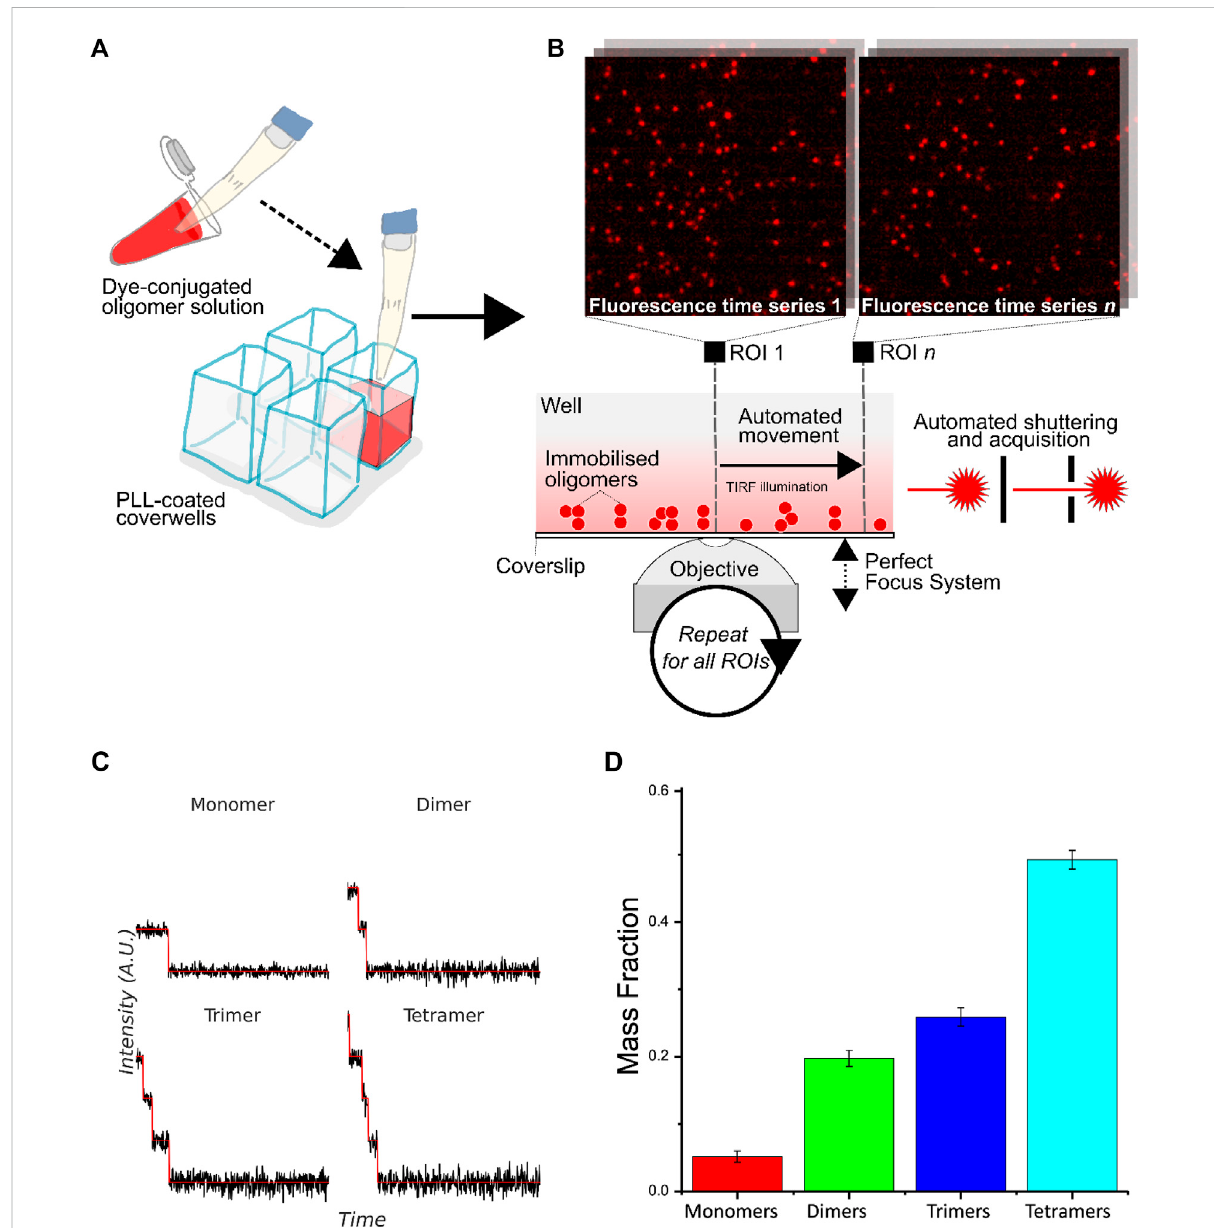
FIGURE 1 Work fl ow of high-throughput protein oligomer analysis by single-molecule stepwise photobleaching. (A) Dye-labeled protein sample is immobilized onto a solid-phase substrate or lipid membrane inside cover glass-bottomed chambers. (B) Overview of the automated acquisition process. Anautomatedpiezoelectricstageisusedtorapidly acquirelarge numbersofphotobleachingtracesoverpresetregionsofinterest(ROIs)in theglasswell.ImmobilizedoligomersareviewedwithTIRFilluminationwithfocusmaintainedoverlargedistanceswithacomputer-controlled focusing system, with each fl uorescence time series acquired automatically via custom control software automating laser shuttering and image acquisition. Example images of immobilized oligomers from two different ROIs are shown. (C) Illustrative idealized photobleaching traces for a monomer,dimer,trimer,andtetramer. (D) Normalizeddistributionofthenumberof fl uorophoresinCD209tetramersdeterminedexperimentally(N ~